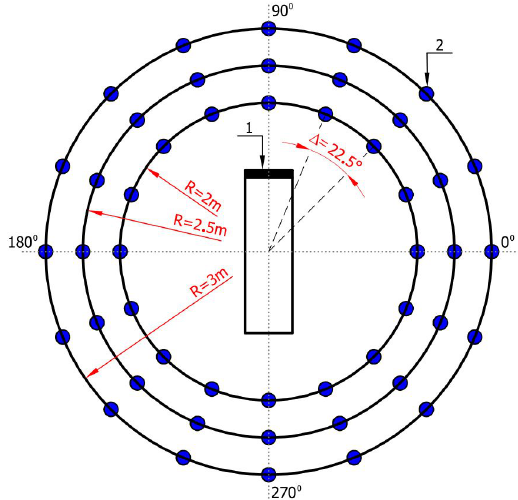
Figure 5: Test station 1) waveguide output, 2) sound level